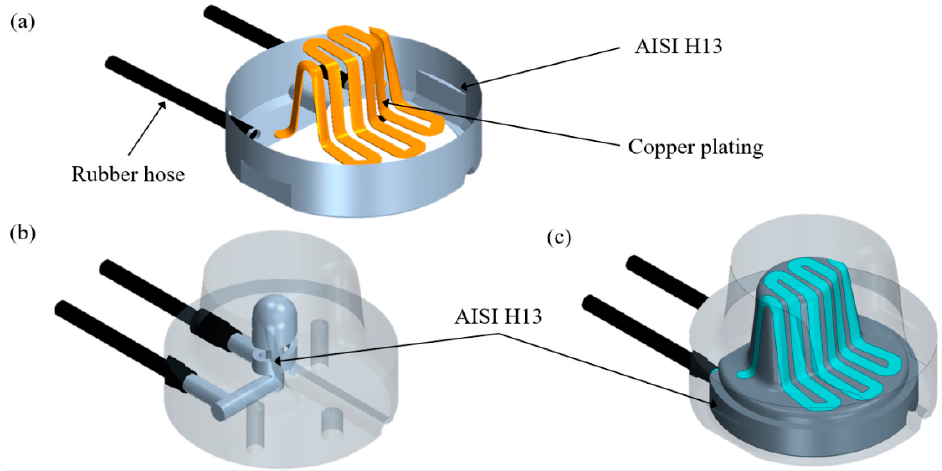
Figure 16. Various cooling channel models to validate the fatigue life prediction methodology. ( a ) Copper plating conformal cooling channel model (Cu CCC). ( b ) H13 straight drilled channel model (SDC). ( c ) AISI H13 conformal cooling channel model (H13 CCC).